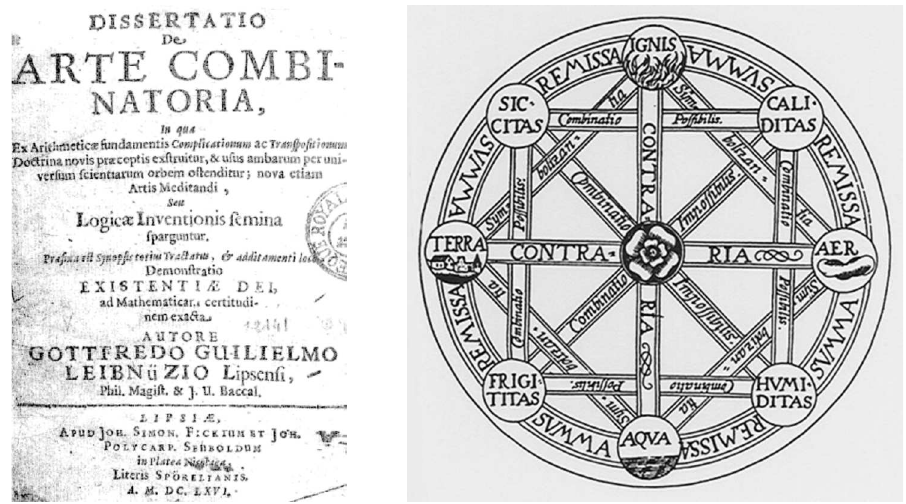
Figure 11. Leibniz’ De Arte Combinatoria and the diagram of